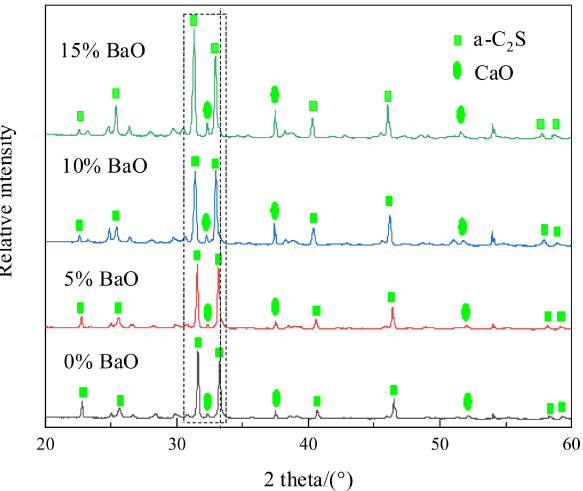
Figure 10. XRD analysis of the C 2 S–C 3 P solid solution with varying BaO